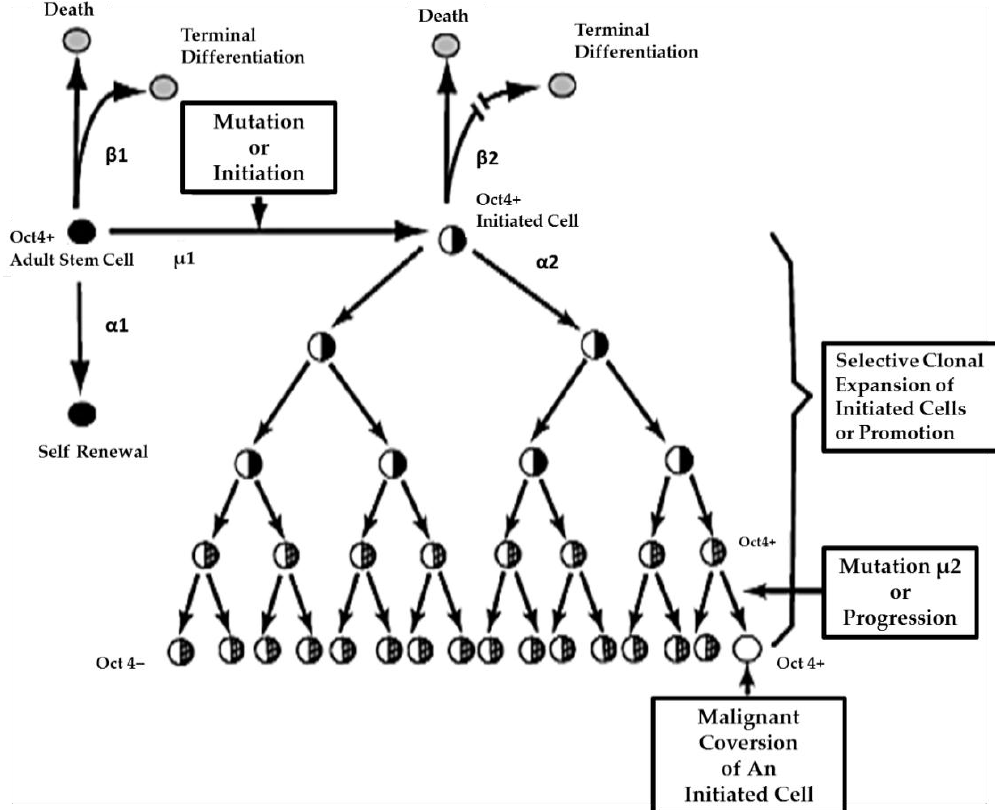
Figure 6 . In this diagram, a normal adult stem cell is shown dividing asymmetrically to form one daughter that is committed to ultimately, terminally differentiate. The other daughter is designated to be identical to its mother adult stem cell (Oct4+). If that adult stem cell is exposed to some condition that prevents asymmetrical cell division but does not suppress Oct4 expression, it is operationally an initiated cell. That is, if mitotically stimulated to divide, it divides symmetrically to form two initiated, non-terminally differentiated cells. Initiation is, then, defined as the process that prevents an immortal normal adult stem cell from terminally differentiating or becoming “mortal.” These adult initiated stem cells are still Oct-4 positive or benign cancer stem cells. As these initiated Oct4+ cells are stimulated to proliferate and resist apoptosis, the growing benign tumor microenvironment changes and some of these initiated Oct4+ cells can partially differentiate into cancer non-stem cells (Oct4 negative). Eventually, additional stable mutational or epigenetic events occur, provoking the benign Oct-4+ cancer stem cells to become invasive, metastatic cancer stem cells. Permission granted by Nova Science Publishers Credit Line Information. In: Trosko, J.E. [81].